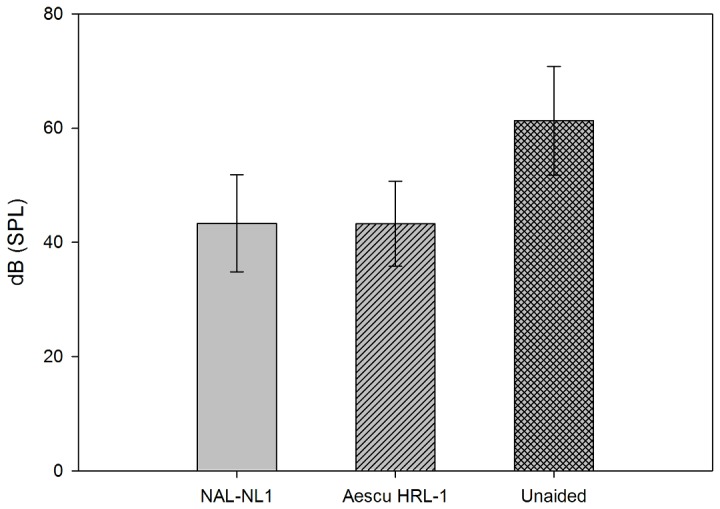
Presentation level required for a 50% correct rate in the MHINT in quiet for the 15 subjects at a moderate speech level.Data show mean and standard deviation values.